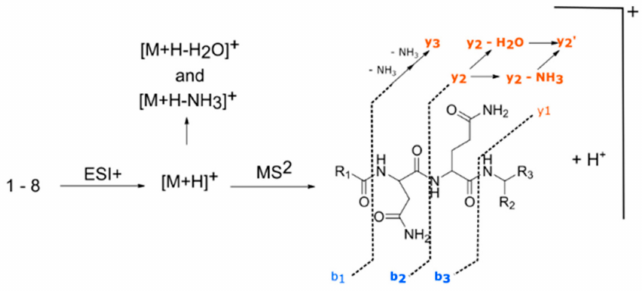
Figure 3. Description of molecular diversity for the di ff erent fellutamides observed. Table 2. Fellutamide derivatives identified from Aspergillus pachycristatus NRRL